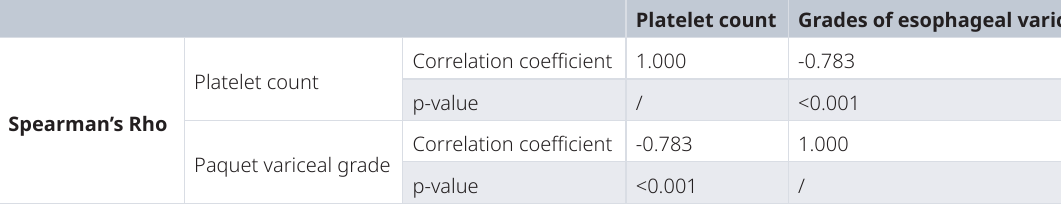
Table 2. Correlation of platelet count with grades of esophageal varices.